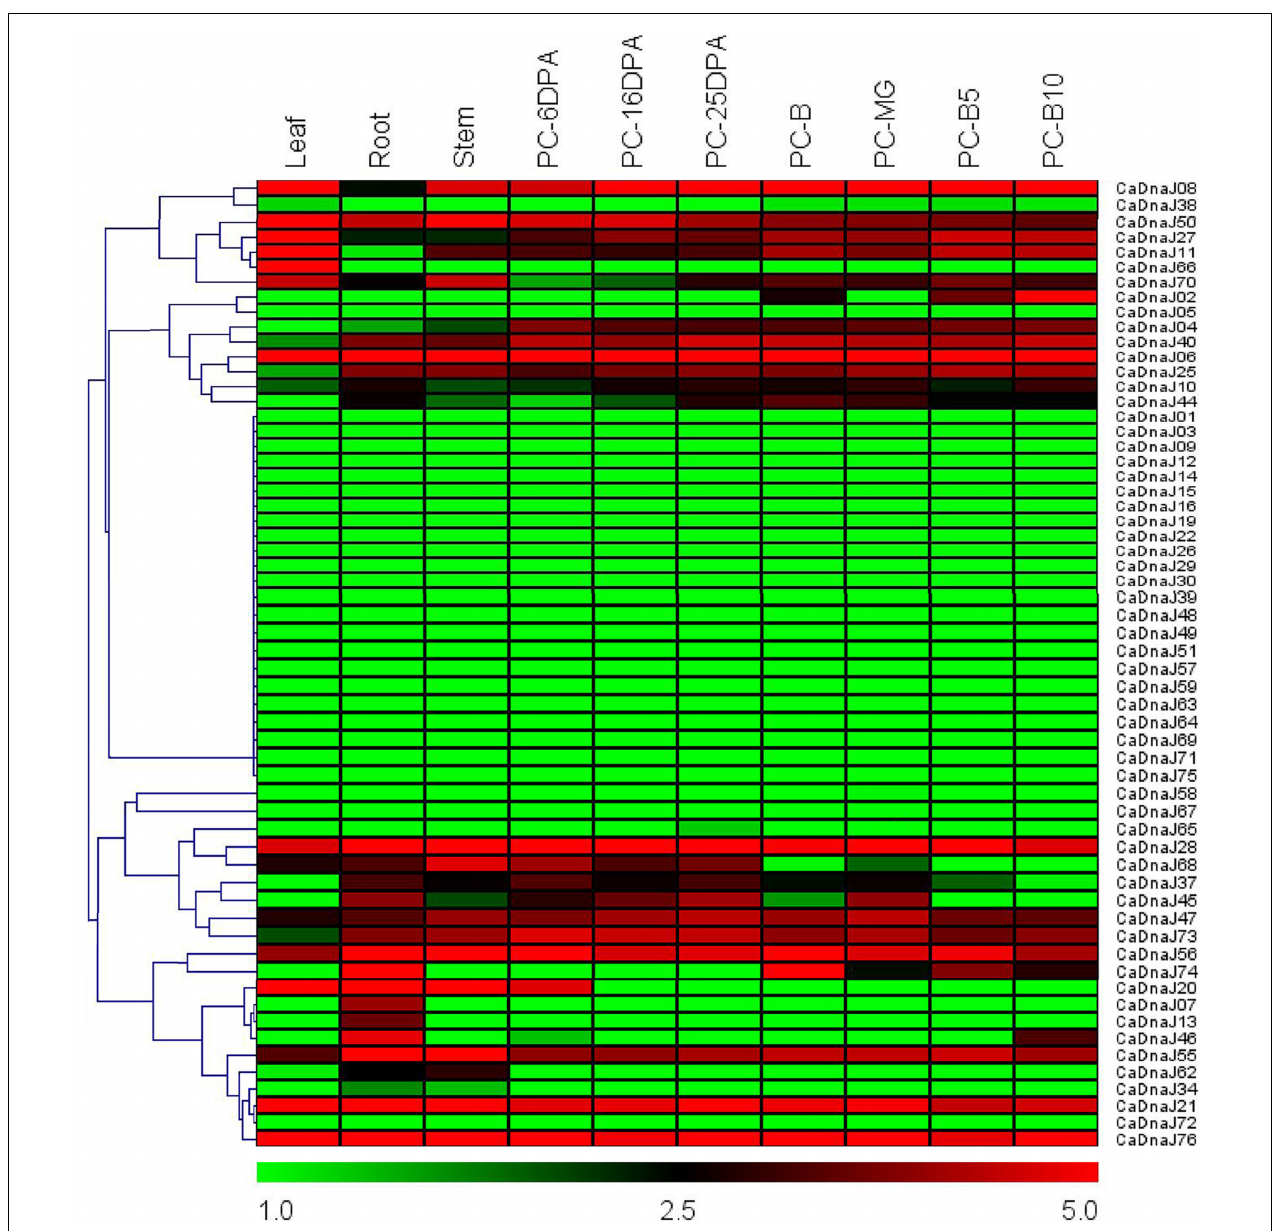
FIGURE 3 | Heat map of the expression profiles of CaDnaJ genes in various tissues. The tested tissues are root, leaf, stem, and pericarp. PC, pericarp; MG, mature green; B, breaker; B5, 5 days post-breaker; B10, 10 days post-breaker; 6 DPA, 6 days post-anthesis; 16 DPA, 16 days post-anthesis; 25 DPA, 25 days post-anthesis. Fragments per kilobase of exon model per million mapped (FPKM) values were log2-transformed and heat maps with hierarchical clustering were exhibited using the software Mev